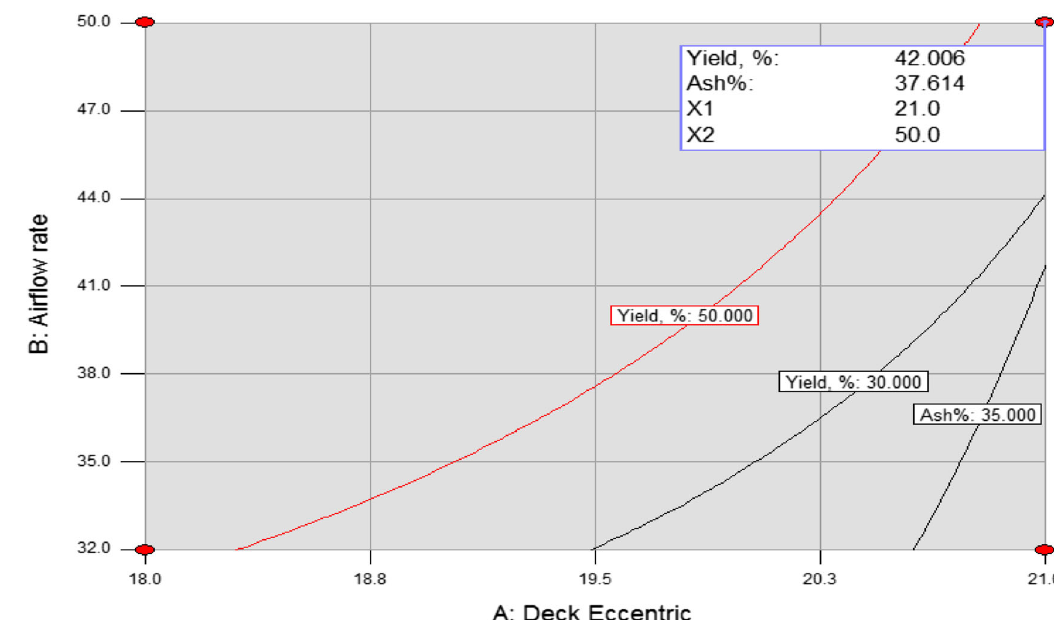
Fig. 10 Optimization with respect to deck eccentric and airflow rate